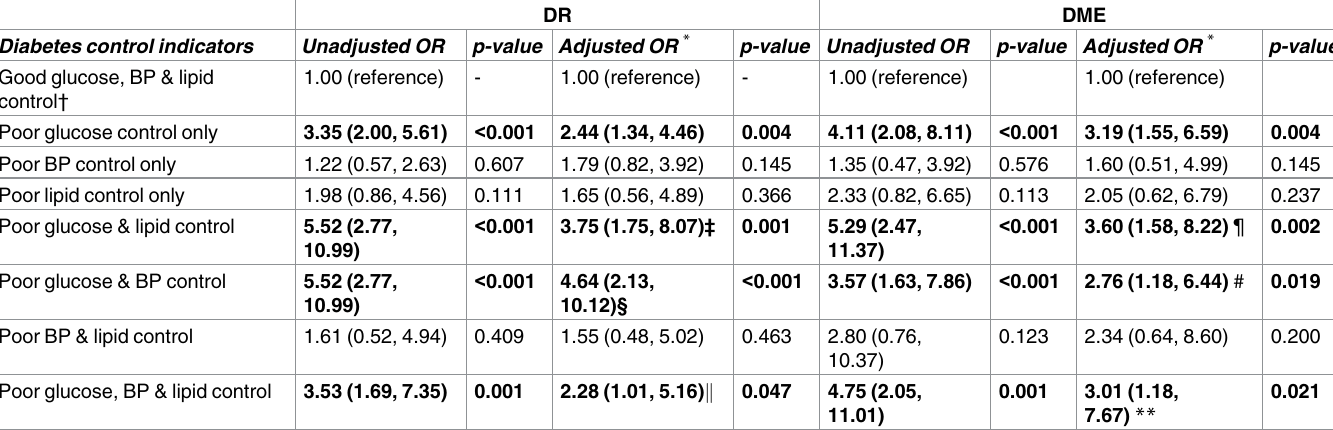
Table 2. Association between individual and combined indicators of diabetes control and presenceof DR and presenceof DME.